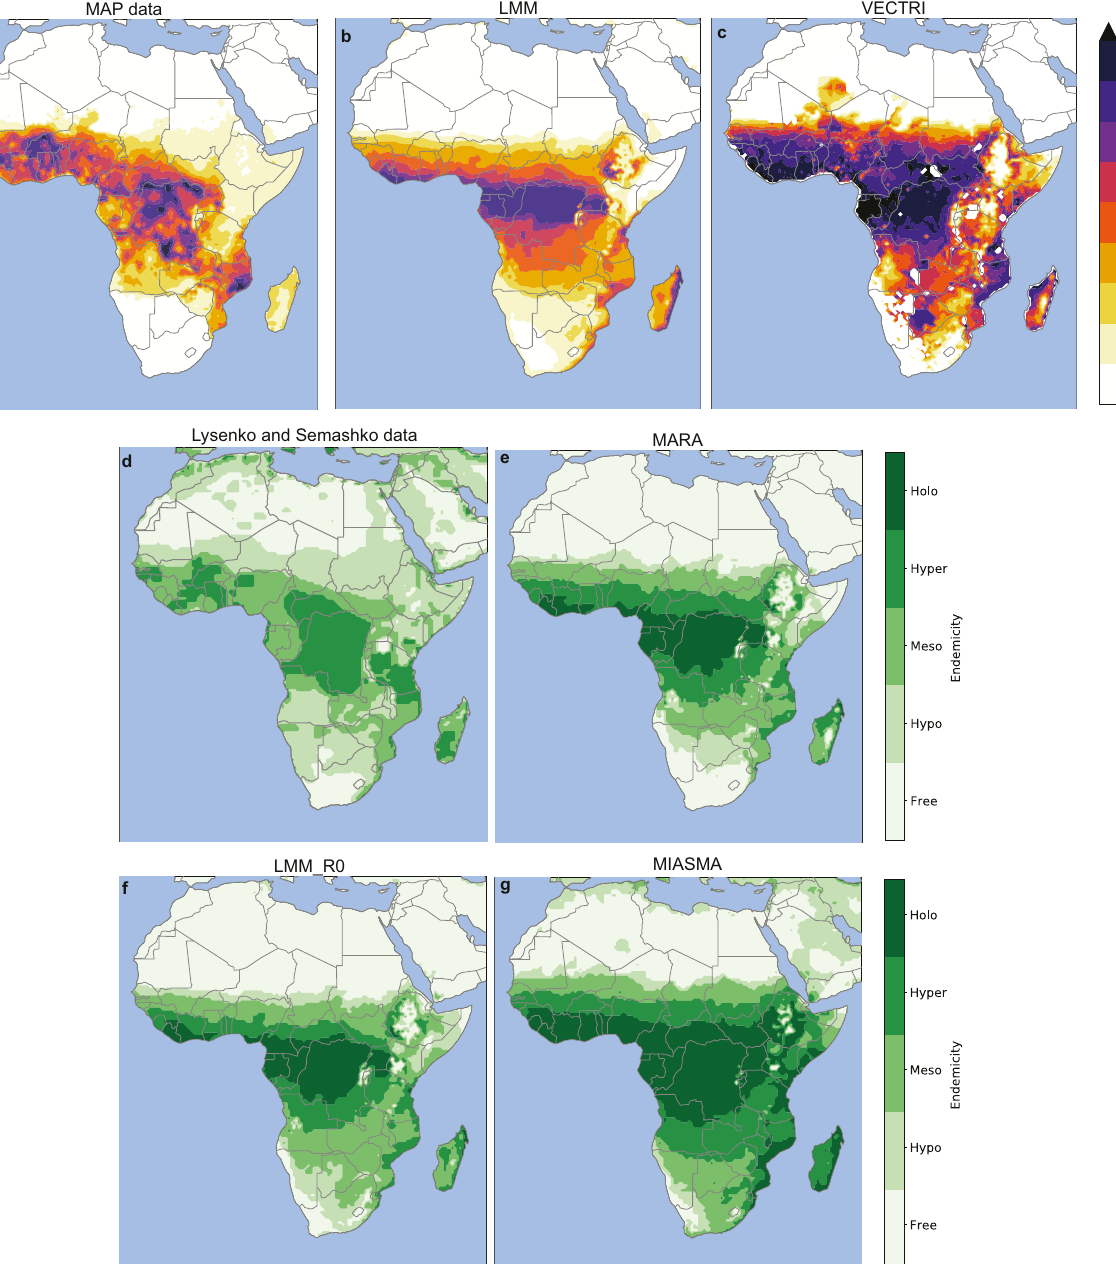
Fig. 1 Malaria model validation maps. a Averaged MAP prevalence data for 2000 – 17. Averaged prevalence (%) for b LMM and c VECTRI. d Lysenko and Semashko malaria endemicity classes for 1900s. Endemicity classes for 1951 derived from e MARA, f LMM_ R 0 and g